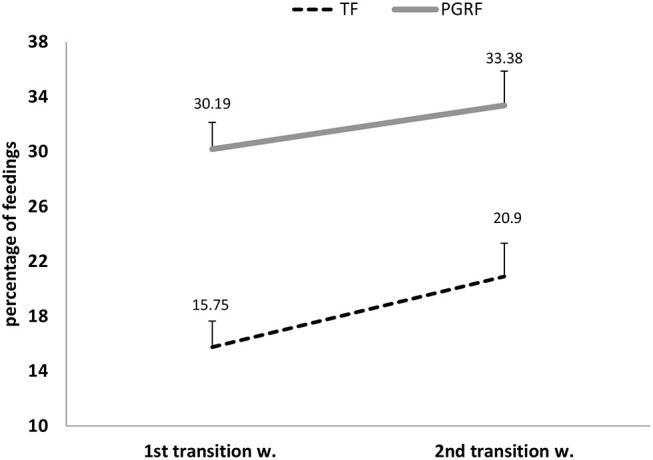
Parental active feeding (percentage) during the intervention among the study groups. PGRF, parental guided responsive feeding; TF, traditional feeding. Analysis was based on repeated measure analysis.Three main effects were tested:1. Effect for Time F(1, 64) = 5.082 p = 0.028, partial eta-squared (ηp2) = 0.074 (7.4%).2. Effect for group F(1, 64) = 20.01 p < 0.001, partial eta-squared (ηp2) = 0.238 (23.8%).3. Interaction effect (Time*Group) F(1, 64) = 0.283 p = 0.597, partial eta-squared (ηp2) = 0.004 (0.4%).[The effect sizes express the amount of variance accounted for by one or more independent variables].